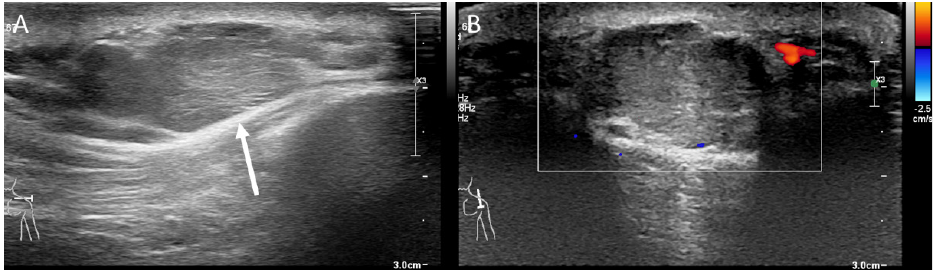
Figure 1. Transverse ultrasound scan shows lobulated hyperechoic mass (arrow) with internal striations in the subcutaneous layer of the posterior shoulder ( A ). Longitudinal scan with Doppler shows the mass without significant internal vascularity ( B ).